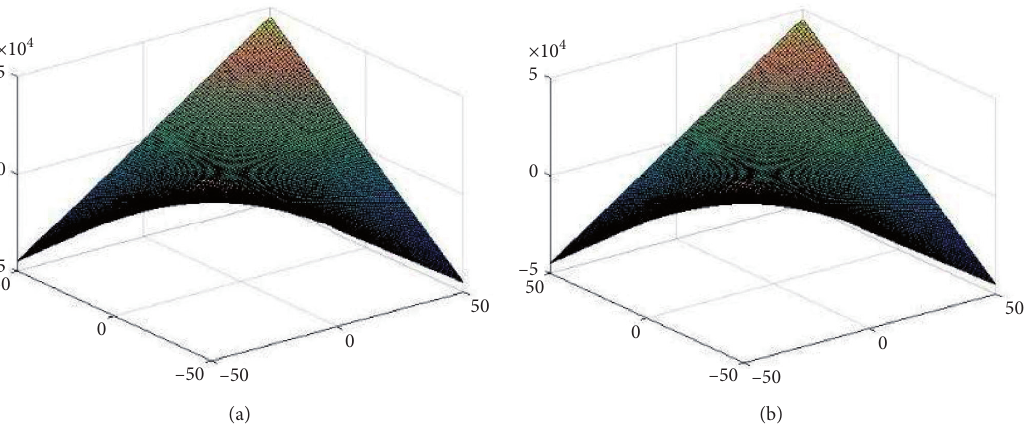
Figure 8: Symmetric division index plotted in